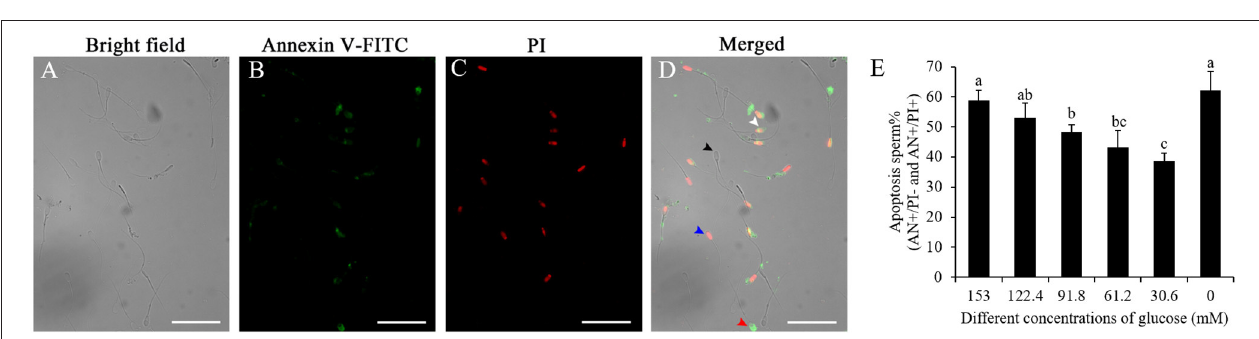
FIGURE 6 | Photos of the boar post-thaw sperm stained with the Annexin V-FITC/PI assay kit (A–D) : live sperm (AN-/PI-; black arrow), early apoptotic sperm (AN + /PI–; red arrow), late apoptotic sperm (AN + /PI + ; white arrow), and non-viable necrotic sperm (AN–/PI + ; blue arrow). Effects of different concentrations of glucose on boar post-thaw sperm apoptosis (E) . Values are specified as mean ± standard deviation. Columns with different lowercase letters differ significantly ( p < 0